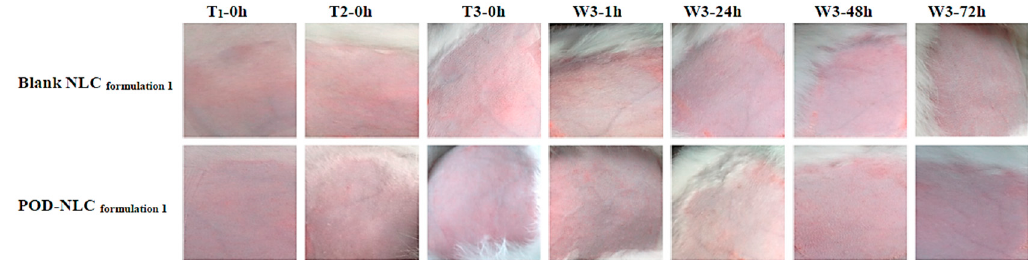
Figure 6. Images of intact rabbit skin before and after three topical administrations of POD-NLC formulation 1 or blank NLC formulation 1 . Notes: T 1 -0 h, T 2 -0 h and T 3 -0 h represent immediately before the first, second, and third times of administration; W3-1 h, W3-24 h, W3-48 h, and W3-72 h last